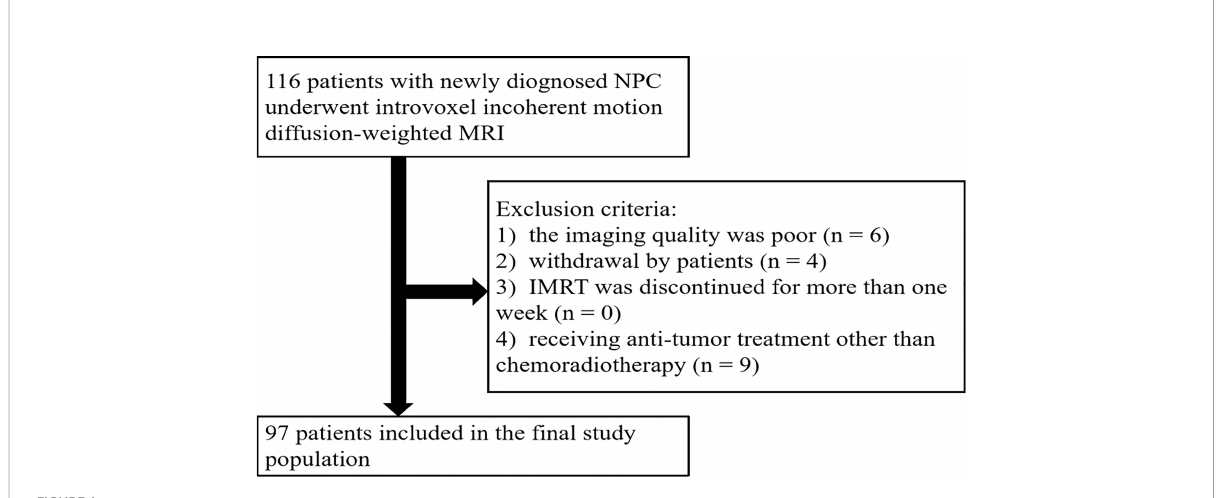
FIGURE 1 The fl owchart of patient inclusion and